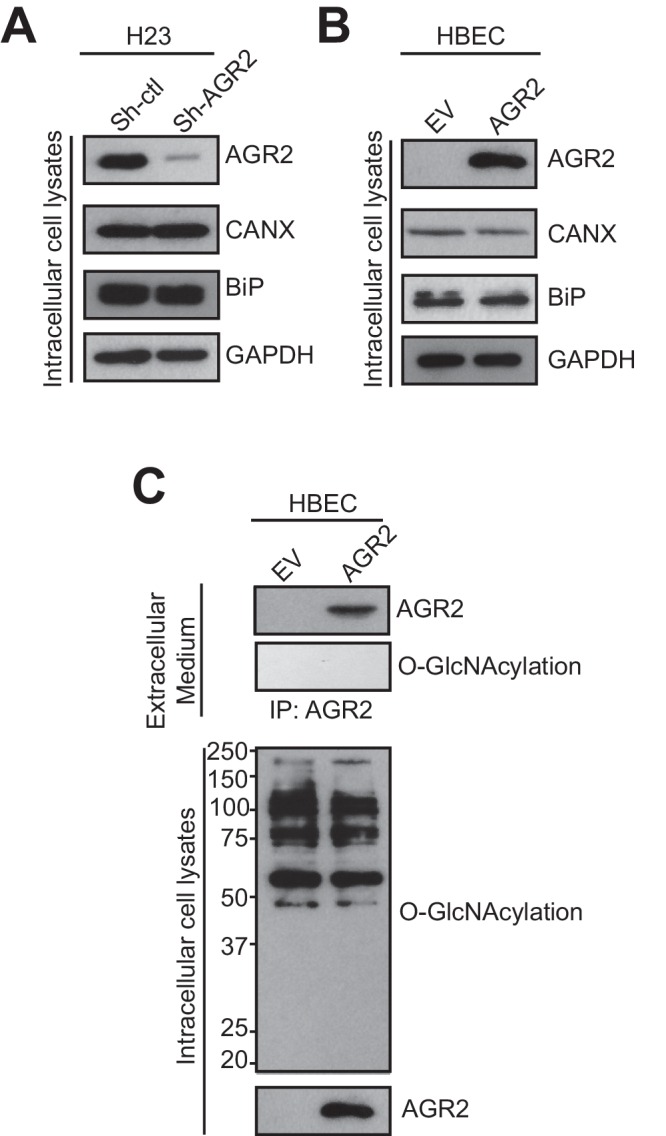
AGR2 expression does not alter the secretory pathway and AGR2 secreted is not O-GlcNacylated.(A) Proteins in the intracellular lysate in H23 organoids silenced (Sh-AGR2) or not (Sh-ctl) for AGR2 were subjected to immunoblotting with anti-AGR2 antibody. GAPDH is shown as loading control. The transmembrane protein Calnexin (CANX) and the KDEL containing protein BiP are shown as control ER-resident proteins in intracellular lysates. One representative experiment (n = 3) is shown. (B) Proteins in the intracellular lysate in HBEC infected with either empty vector (EV) or AGR2, as analyzed by immunoblot with anti-AGR2 antibody. GAPDH concentrations are shown as loading control. The transmembrane protein Calnexin (CANX) and the KDEL containing protein BiP are shown as control ER-resident proteins in intracellular lysates. One representative experiment (n = 3) is shown. (C) Extracellular AGR2 from medium organoid lysates of HBEC organoids infected with either empty vector (EV) or AGR2 was immunoprecipitated with anti-AGR2 antibody and immunoblotted with anti-AGR2 or anti-O-GlcNAc antibodies. Intracellular organoid lysates were also probed with anti-AGR2 and anti-O-GlcNAc antibodies. One representative experiment (n = 3) is shown.